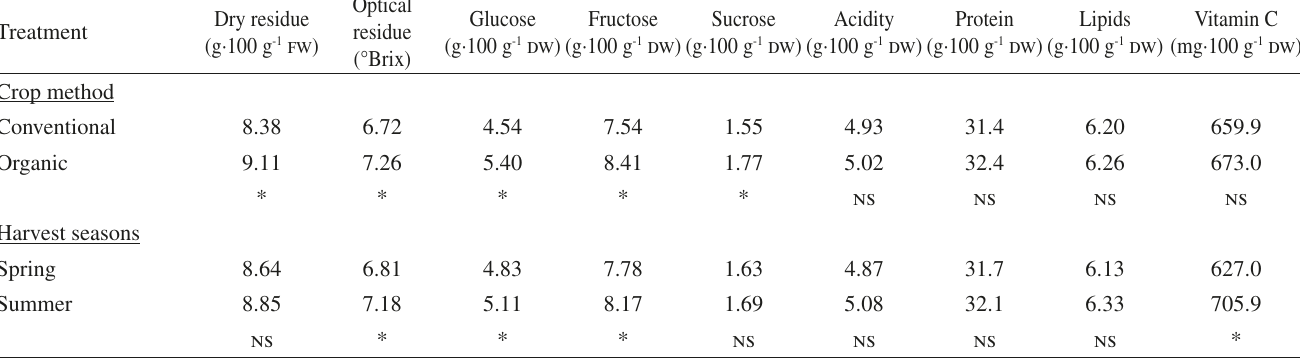
Table 4 - Asparagus spear quality as influenced by crop method and harvest seasons Treatment